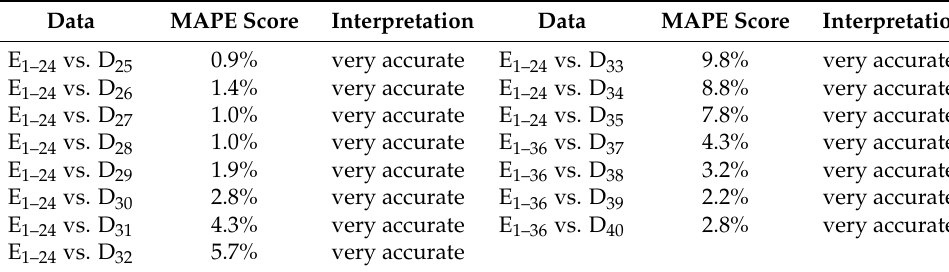
Table 3. The results of the MAPE calculation and interpretation for the prediction.